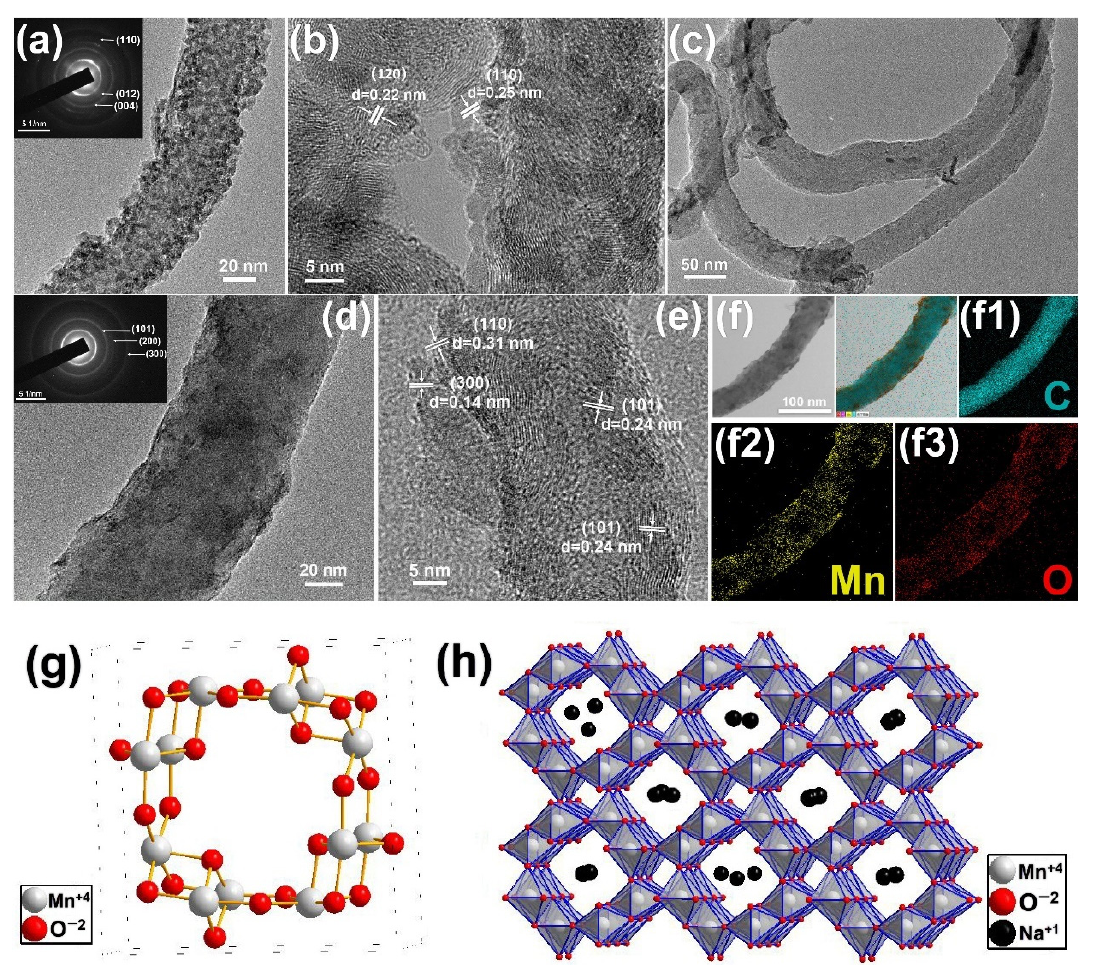
Figure 4. ( a ) TEM image and SAED pattern and ( b ) HR − TEM image of the Fe 2 O 3 @CNTs core − shell structure; ( c , d ) TEM image and SAED pattern, ( e ) HR − TEM image and ( f ) The STEM image (left), total EDS element mapping (right) and the corresponding EDS mappings of C (f1), Mn (f2), O (f3) elements of α -MnO 2 @CNTs core − shell structure; ( g ) the unit cell of α -MnO 2 ; ( h ) crystal structure of α -MnO 2 with one-dimensional pore morphology and schematic diagram of sodium ion adsorption and embedding in pore structure.